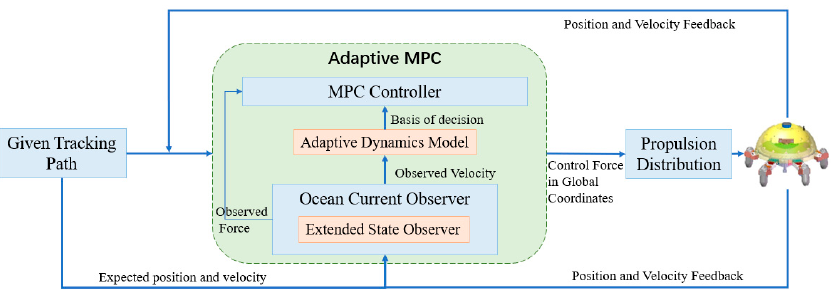
Figure 3. The adaptive model predictive control (AMPC) control strategy with ocean current observer.